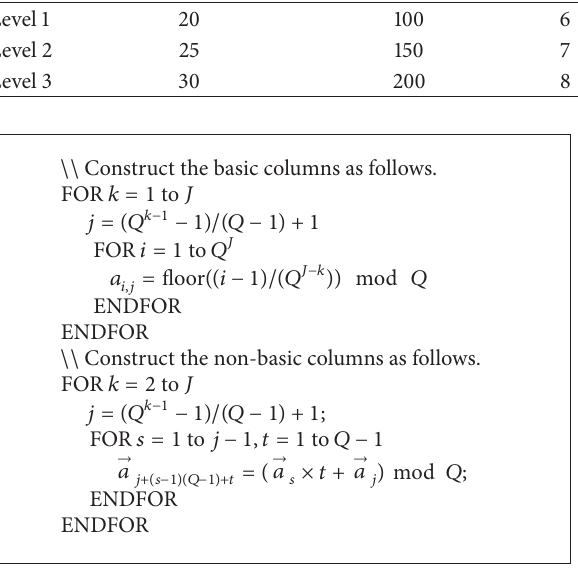
Algorithm 1: Constructing the orthogonal array 𝐿 𝑀 (𝑄 𝑃 )